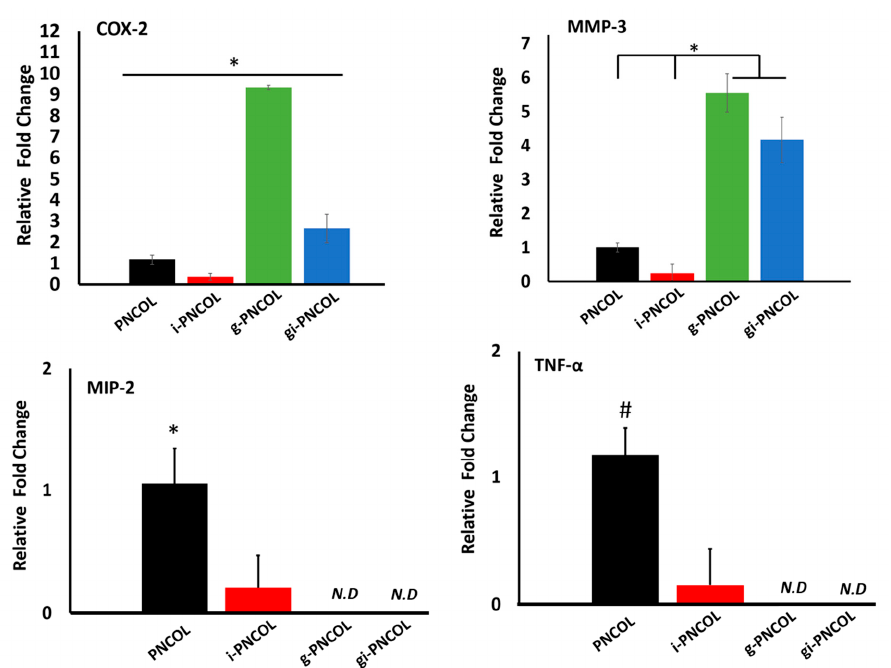
Figure 8. The relative expression of pro-inflammatory (M1) Genes. Star sign (*) indicates a significant difference between sample groups ( p < 0.05). The pound sign (#) indicates a significant difference between sample groups ( p < 0.1). N.D indicates Not Detected gene expressions.